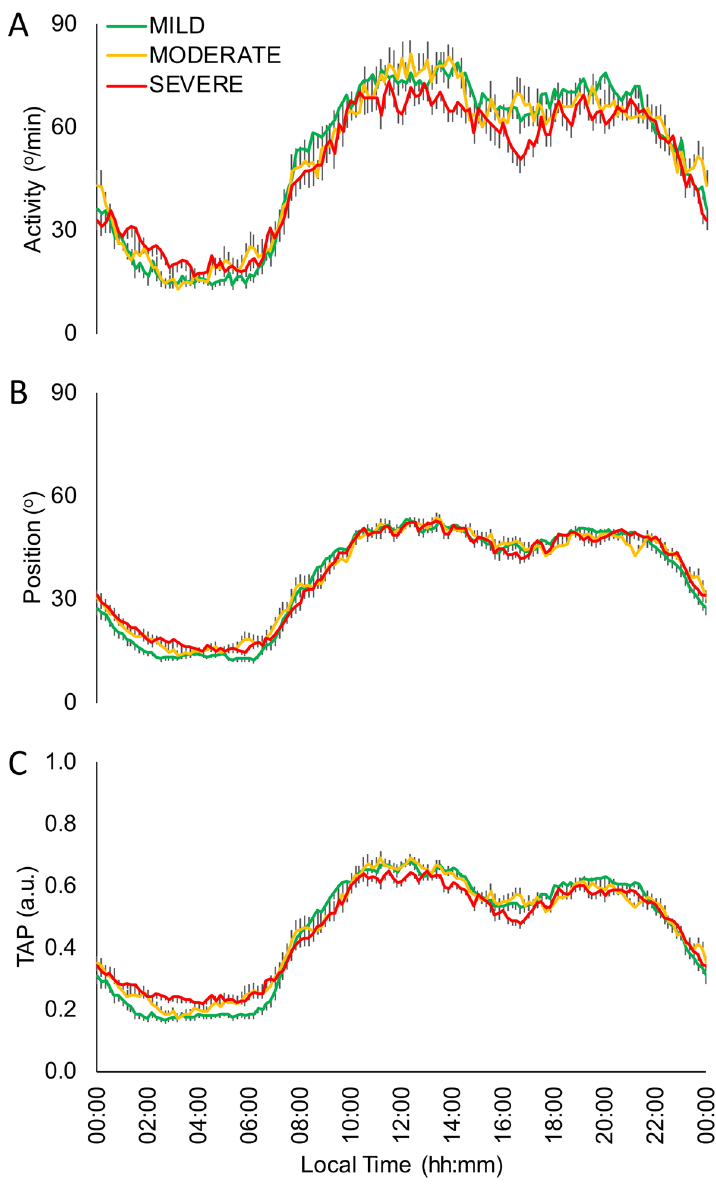
Figure 3. Mean waveforms for mild, moderate and severe SDB subjects according to their Apnoea/Hypopnoea Index for: ( A ) Activity (º/min), ( B ) Body Position (º) and ( C ) integrated variable TAP (a. u.). Snorer / Mild group: subjects with less than 15 events/hour (green line, n: 31); Moderate: between 15 and 30 events/hour (yellow line, n: 19); Severe: more than 30 events/hour (red line, n: 28). All data are expressed as mean ±